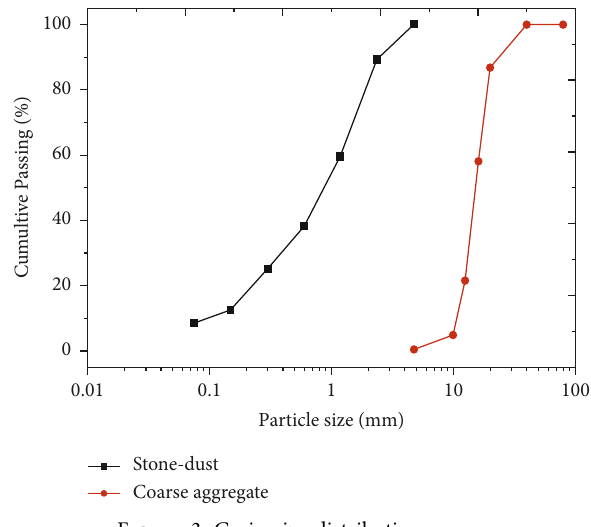
Figure 3: Grain size distribution